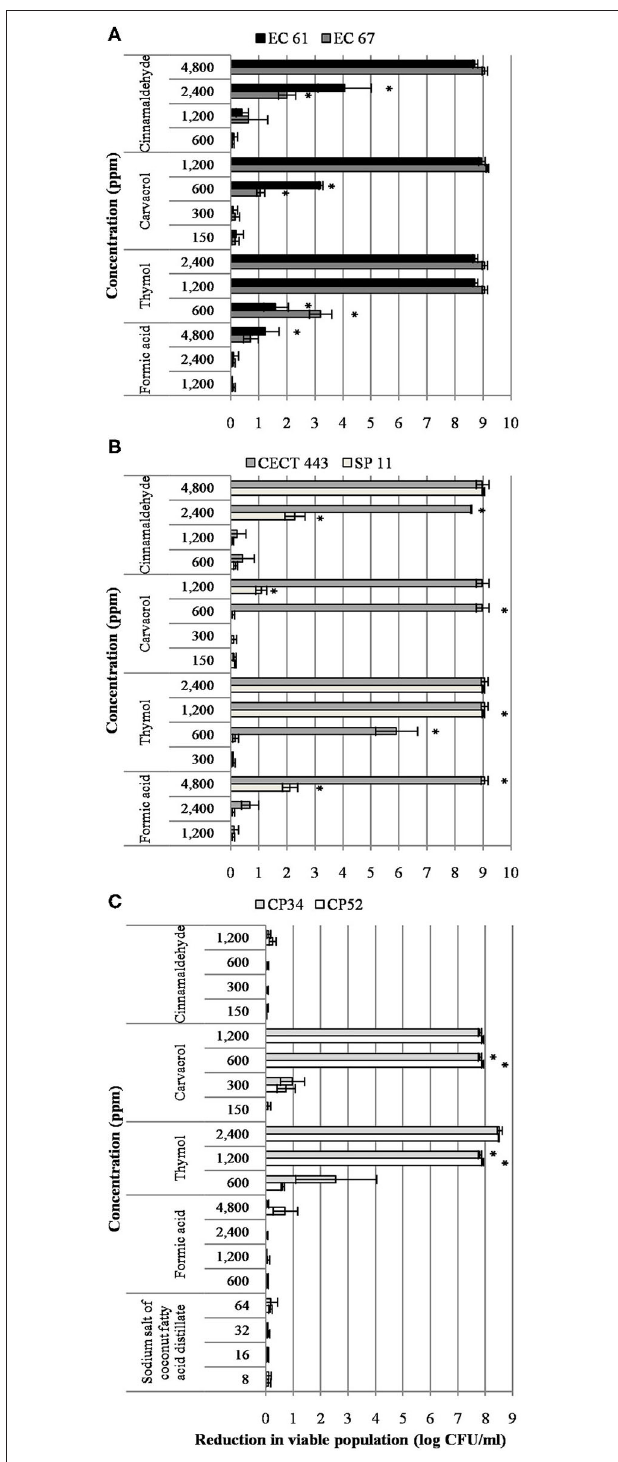
FIGURE 1 | Reduction in viable colonies (log CFU/ml) of E. coli (A) , S. Typhimurium (B) , and C. perfringens (C) after the exposure to different concentrations of the tested compound for 90min at room temperature. Data are expressed as mean of the three independent replicates ± standard deviations. *Denotes the lowest concentration of product in which population viability differed significantly with respect to controls ( p <